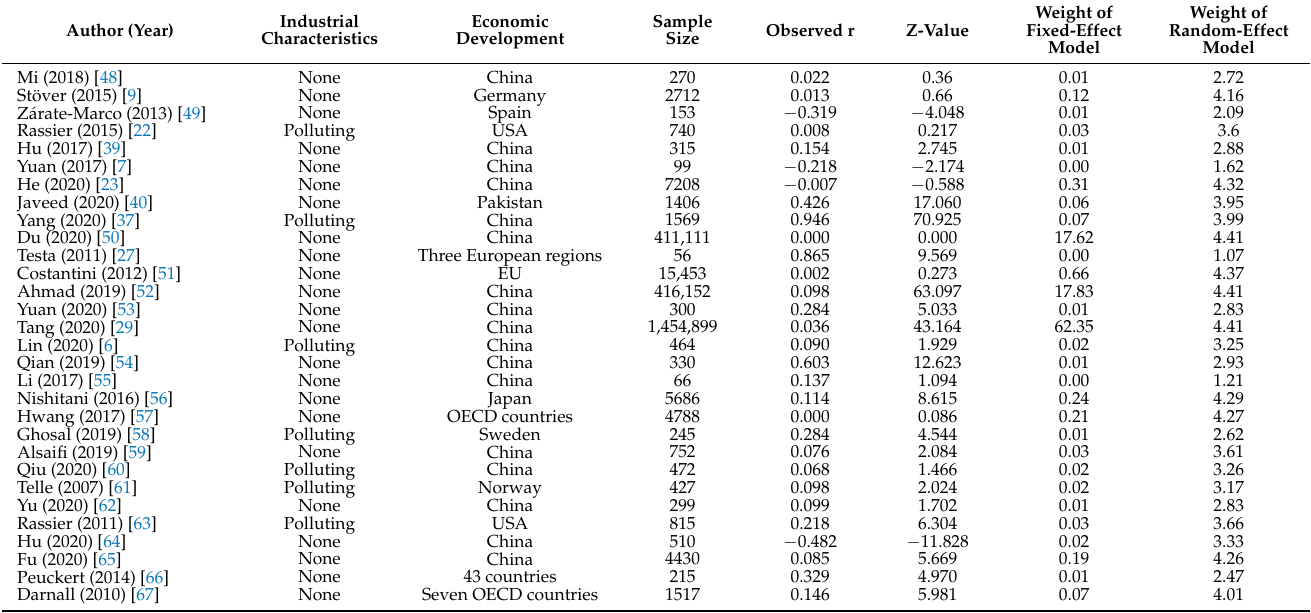
Table 1. Partial coding information and effect size of